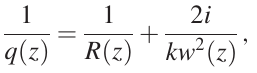
ffiffiffiffiffiffiffiffiffiffiffiffiffiffiffiffiffiffiffiffiffiffiffi p 1 þ ð z=z